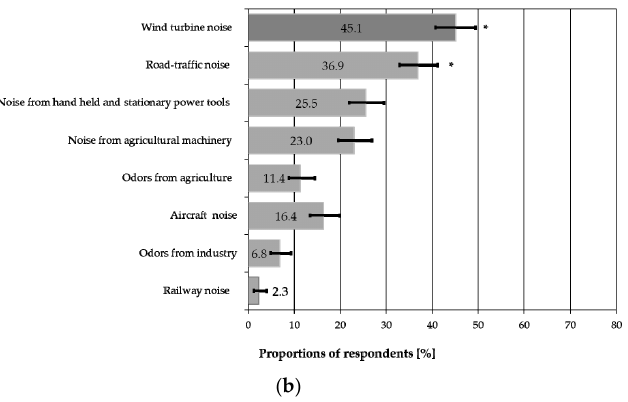
Figure 2. Comparison of proportions (with 95% confidence intervals) of respondents who perceived the wind turbine noise and other environmental nuisances ( a ) outdoors and ( b ) indoors. Cases without a significant difference are denoted (*) ( p > 0.00625). For other cases, significant differences were found. Table 5. Comparison of proportions (with 95% confidence intervals) of respondents who were annoyed (or highly annoyed) by the wind turbine noise and other environmental nuisances 1 .